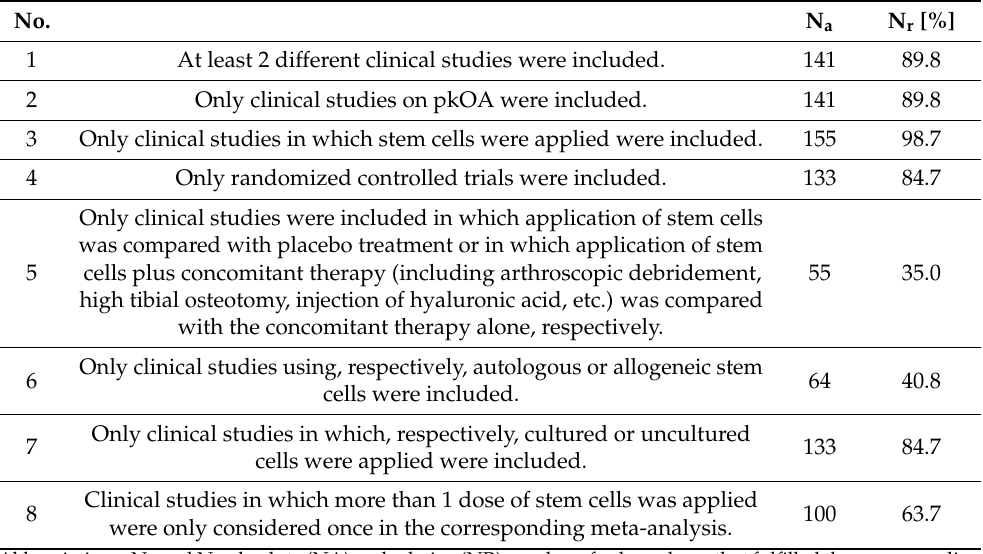
Table 5. Criteria used to assess the quality of sub-analyses in the meta-analyses summarized in Table